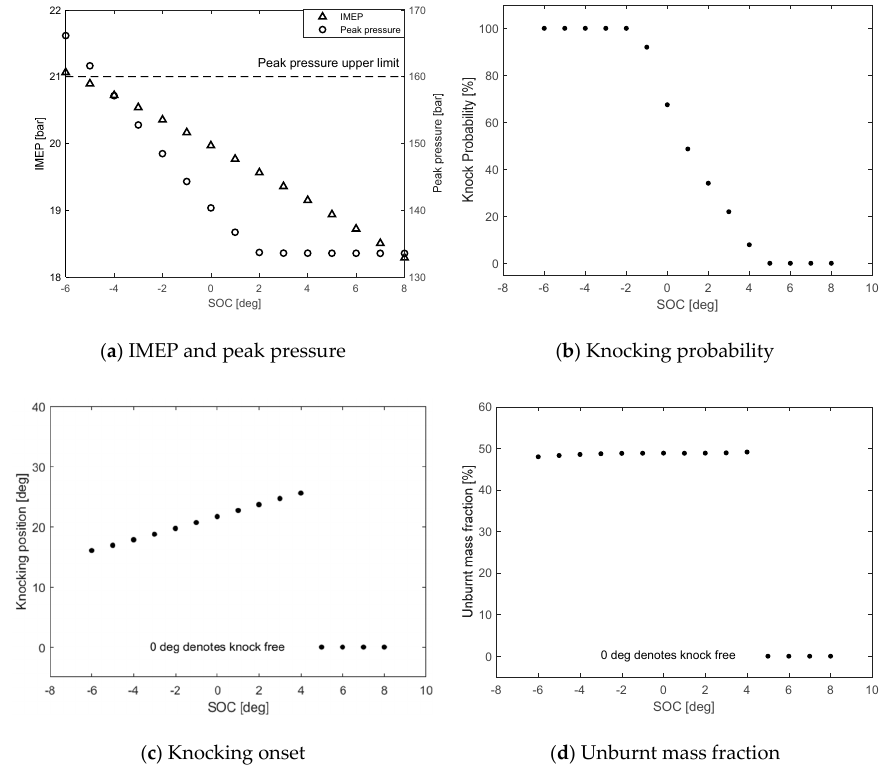
ff ect of ignition timing on engine performance and knocking performance (Engine Figure 10. The effect of ignition timing on engine performance and knocking performance (Engine B). Figure 10. The e